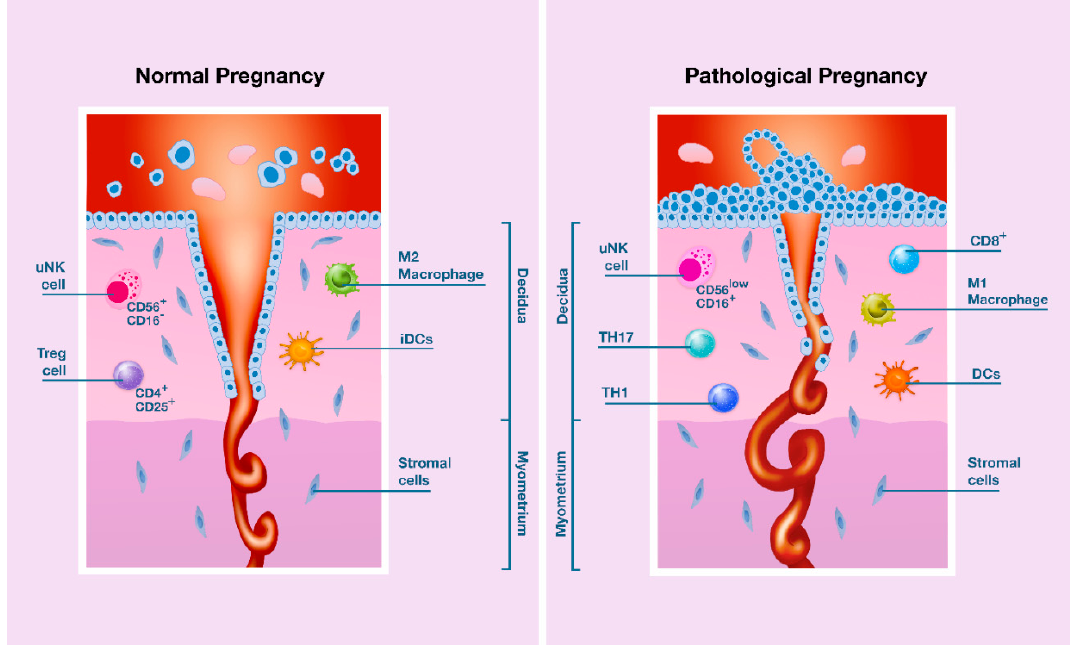
Figure 2. Reduced invasiveness and remodeling of maternal spiral arteries by trophoblastic cells is associated with a risk of pathological pregnancy.